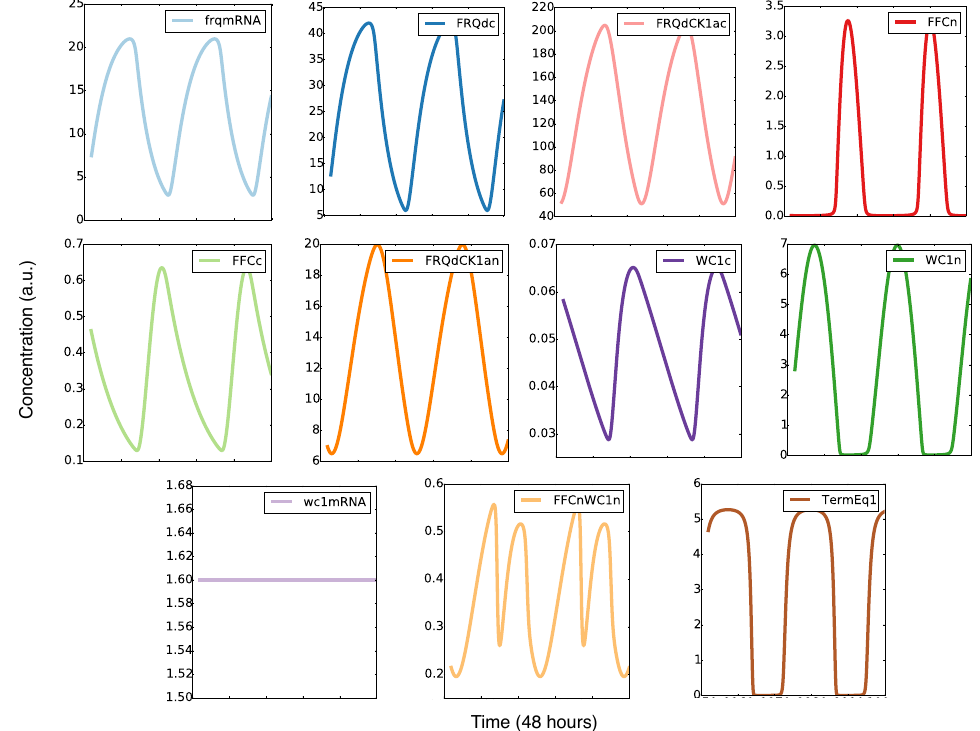
Figure 3. Simulated time series: There are sinusoidal and spike-like waveforms, harmonics, and a temporal switch (see the